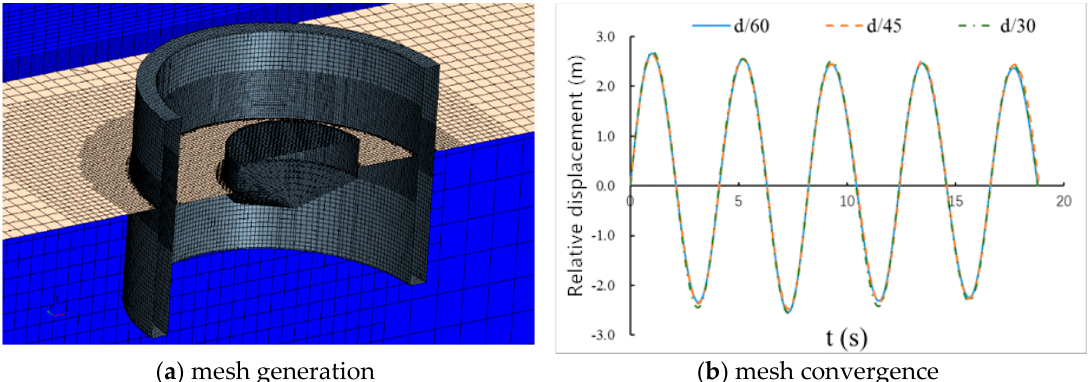
Figure 6. Grid around the moonpool-buoy wave energy converter (WEC) model convergence verification.